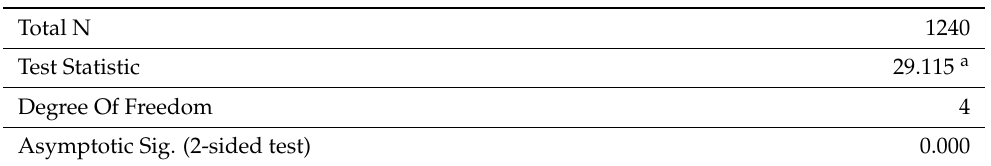
Table 5. Independent-Samples Kruskal–Wallis H Test Summary. The table shows the results of the independent-samples Kruskal–Wallis H test summary between MSN zeta-potential groups’ viability scores.